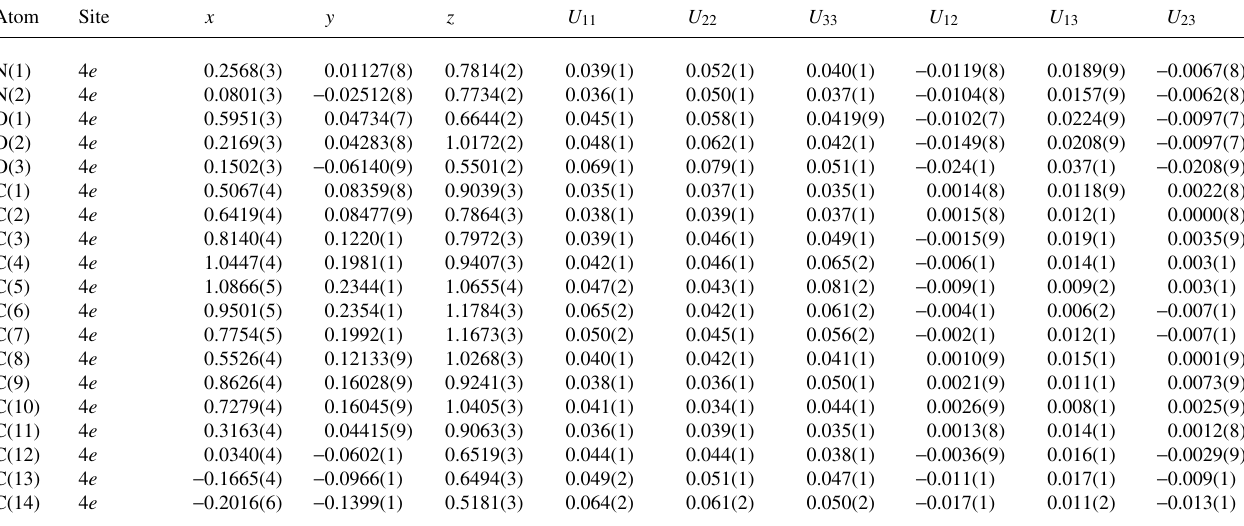
Table 3. Atomic coordinates and displacement parameters (in Å 2 )